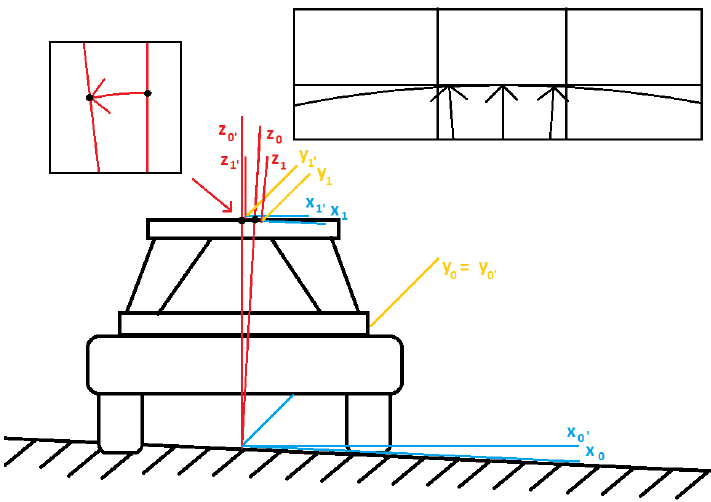
Figure 7. Simulation of falling into holes by a vehicle—the case of rotation around the y axis [Source: MovieBird Intl.].